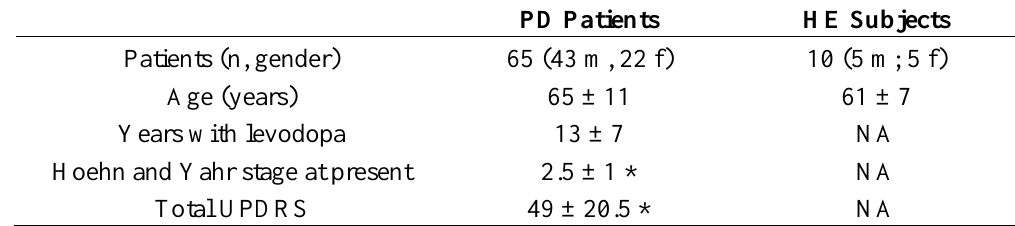
Table 1. Characteristics of Parkinson’s disease (PD) patients and healthy elderly (HE) subjects, presented as median ± inter-quartile